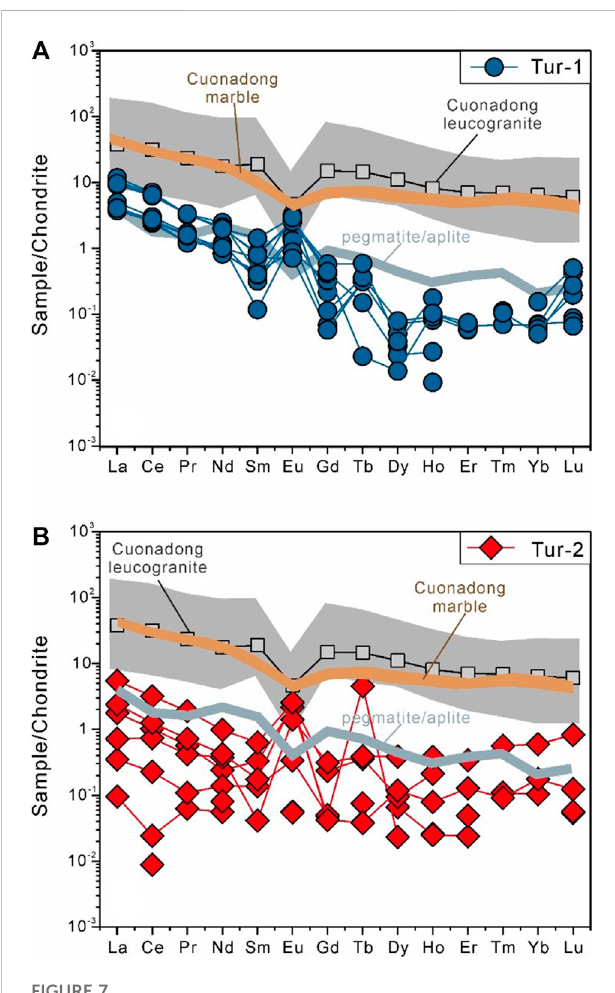
FIGURE 7 Chondrite-normalized REE patterns in Tur-1 and Tur-2. The chondrite values are from Sun and McDonough (1989). The data on Cuonadong leucogranite, pegmatite/aplite, and marble in the Xianglin areaareobtainedfromHuangetal.(2018),Xieetal.(2018),ZhangL. et al. (2019), Xie et al. (2020), and Dai et al. (2022). (A) Chondrite- normalized REE patterns of Tur-1 is shown as blue circle and line. (B) Chondrite-normalized REE patterns of Tur-2 is shown as red rhombus and